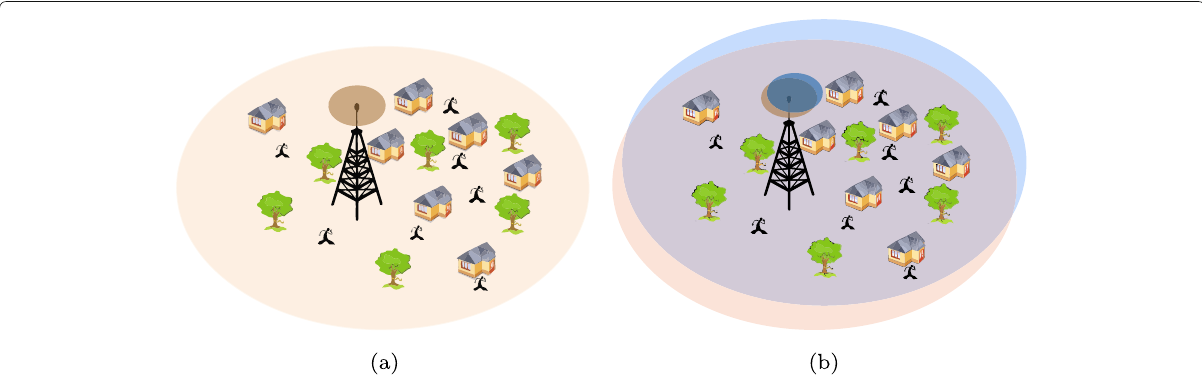
Fig. 1 Configurations assumed for the radio access network with one and two carriers, respectively. a Configuration #1. b Configuration #2